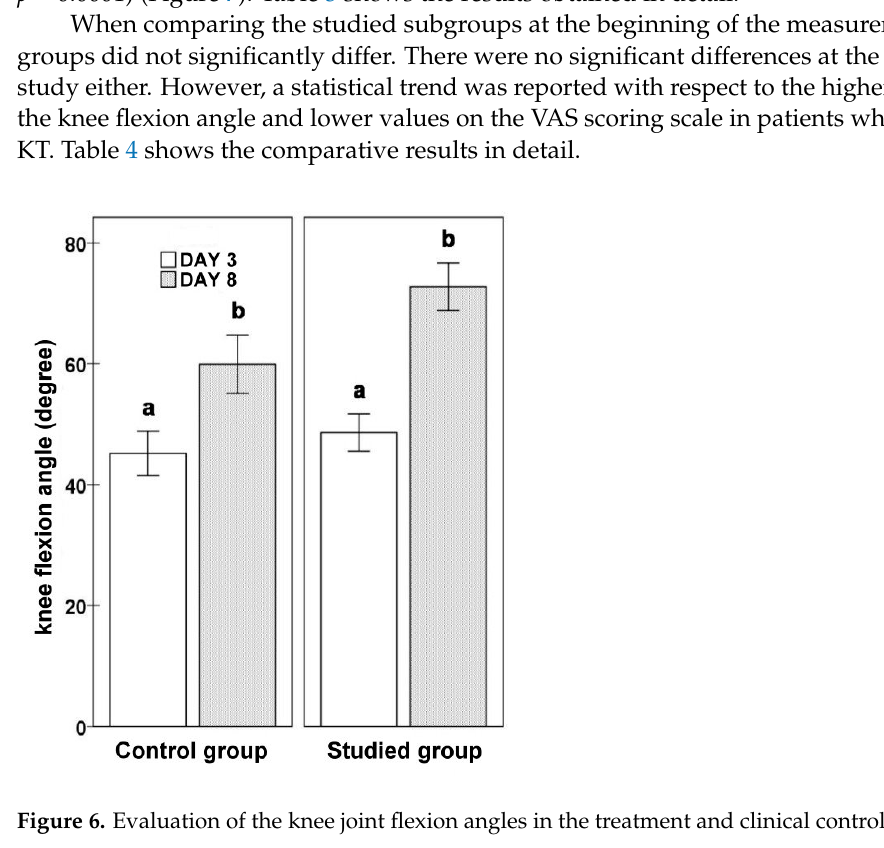
Figure 7. Evaluation of the VAS scale in the treatment group and clinical control groups.